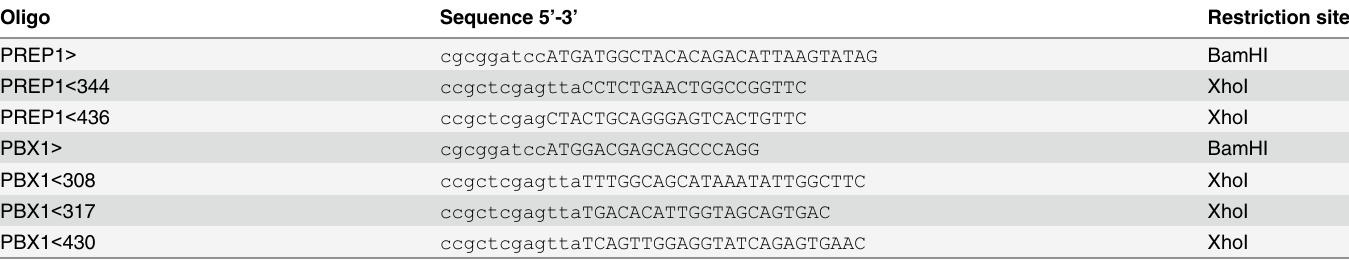
Table 3. Primers used for cloning of PREP1 and PBX1 constructs into PGEX-6p-2rbs.